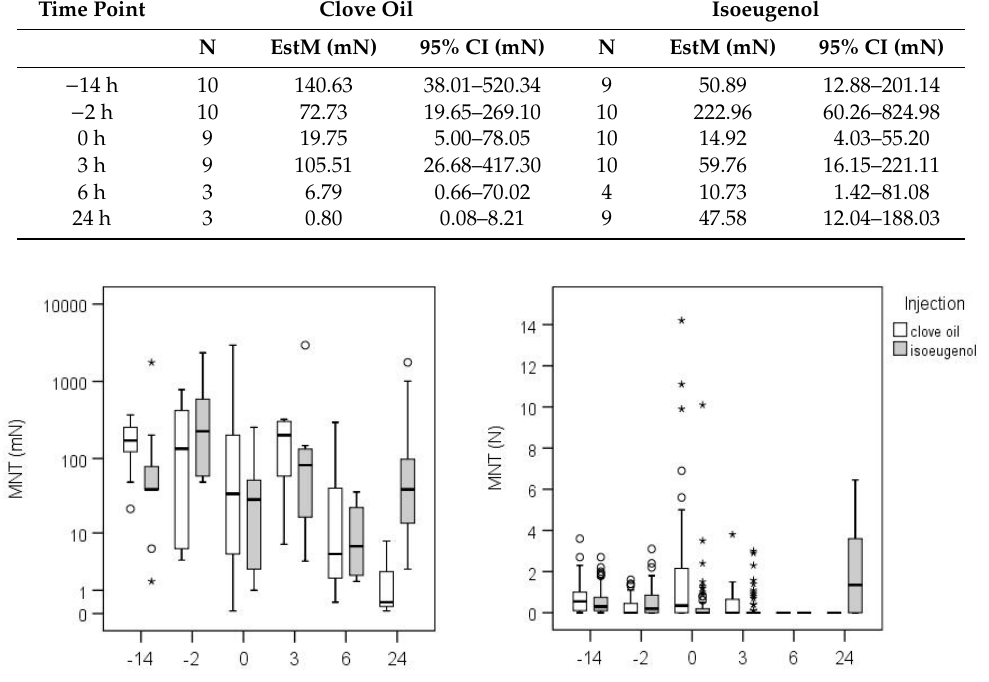
Figure 4. Mechanical nociceptive threshold, measured by von Frey filaments (vFF, left ) or pressure algometer (PA, right ), of the 20 goat kids on the six time points (TP) the day before, i.e., about 14 h before ( − 14), injection of clove oil (white boxes) or isoeugenol (grey boxes), on injection day 2 h before ( − 2), immediately after injection (0) and 3 h (3) and 6 h (6) after injection, and 24 h after injection (24). Graphs are based on original data, please note the different scales: The values of vFF represent target force in mN on a logarithmic scale (ranging from a minimum of 0.08 mN to a maximum of 2.94 N); values of PA are shown in applied force in N. For vFF the median of all six measures per time point (clove oil: N = 10, 10, 9, 9, 3, 3 for TP-14, − 2, 0, 3, 6, 24; isoeugenol: N = 9, 10, 10, 10, 4, 9) is shown, for PA the individual measurement points (i.e., 8 values per animal) are included, N see vFF except for TP 6 and 24, clove oil: N = 2, 2; isoeugenol, N = 4, 6). The Box–Whisker-Plots show median (bar in box), 25 and 75% quartile (bottom and top end of the box) and minimum and maximum (whiskers), except for outliers (circles) and extreme values (asterisks). 4. Discussion In this study, we compare changes in mechanical nociceptive threshold in the first 24 h after the injection of clove oil or isoeugenol for disbudding in calves and goat kids. In both species, the variability of MNT increased markedly after injection, not only with large inter-individual differences but also within individuals and across locations. The results suggest a local anaesthetic effect (MNT increased to the maximum force possible without inducing a response) as well as hyperalgesia/allodynia (lowest measurable MNT or even no full measurement possible with the pressure algometer due to response to touch with no applied pressure) after injections of clove oil or isoeugenol. In addition, we detected differences in post-injection MNT development over time that were more prevalent in goats. 4.1. Calves We found an effect of time and side on the MNT for both isoeugenol and clove oil injection, but no difference between the two treatments. Compared to the measurements before the injection, the data collection was more difficult after injection, since the animals partly withdrew the head at the minimal contact with the measuring device, i.e., before applying any pressure. Consequently, several attempts were necessary to be able to obtain one measurement. Failure to take a complete measurement corresponded to a value of 0. On the other hand, after the injection calves were very insensitive at some locations, i.e., they did not react with head movement, even when the maximum cut-off force was reached. Thus, a high level of variability of MNT, ranging from 0 to the maximum of 20 N, was found for all time points after injection, and variability was larger after injection than before, especially at time points 1 and 24 h post-injections. The insensitivity of calves at some locations, i.e., the complete absence of a withdrawal response even following the application of the maximum possible mechanical pressure, seems to confirm previous observations on the anaesthetic effect of (iso)eugenol (e.g., [9,11,13,14]). The anaesthetic effect/insensitivity was most pronounced one